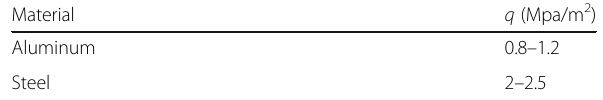
Table 7 q factor for aluminum and steel Material